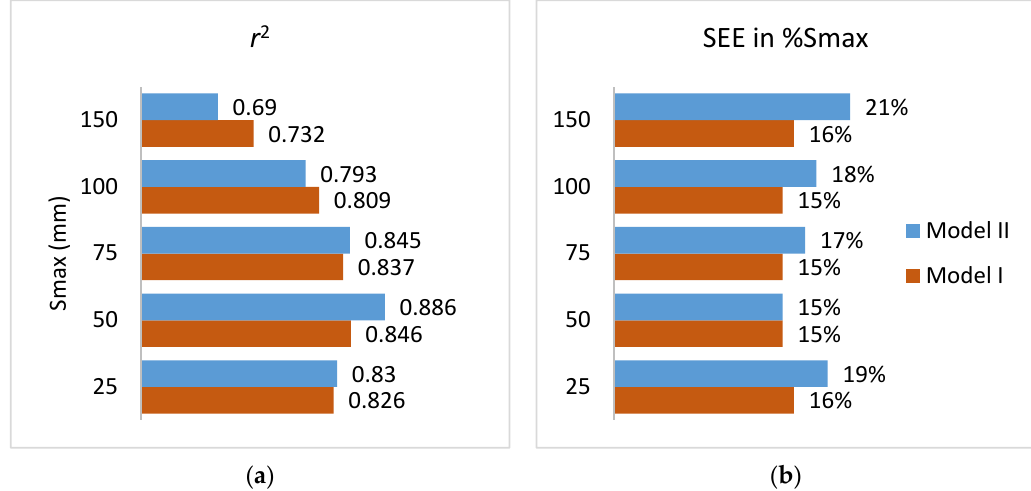
Figure 6. Regression models fitted to the data series: example for Smax 50 mm ( S * stands for S estimates by the regression model).